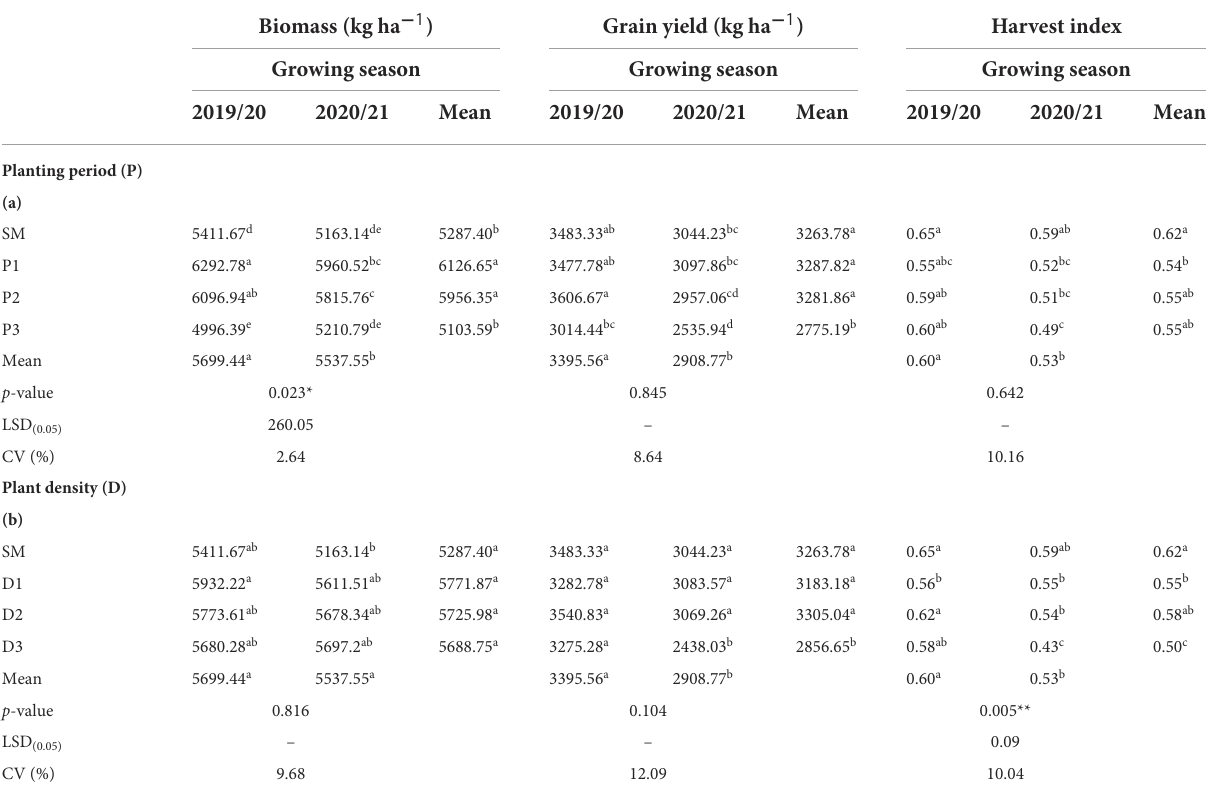
TABLE 3 Effects of sunn hemp living mulch planting period (P) and density (D) on maize biomass, grain yield, and harvest index under the in-field rainwater harvesting technique in the central semiarid area of the Free State Province, South